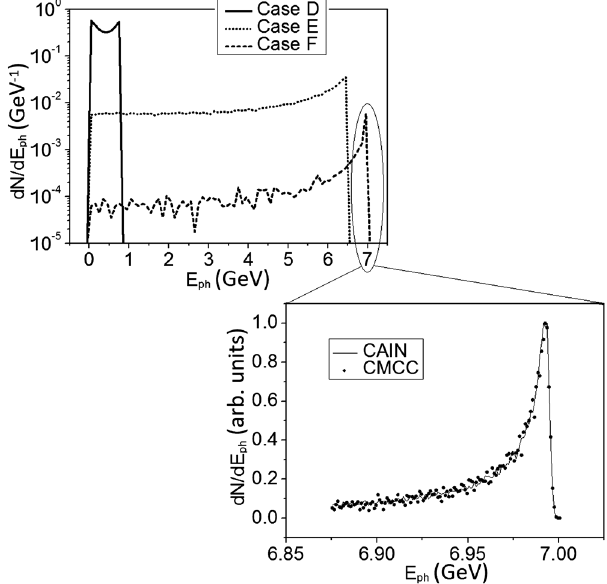
FIG. 4. Spectrum of the emitted photons for the three XFELO- γ cases, CMCC simulations. Close-up for case F with comparison between CAIN and CMCC